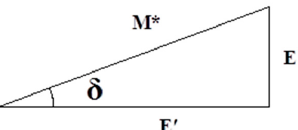
Figure 4. Test setup of dynamic mechanical analyzer (DMA).